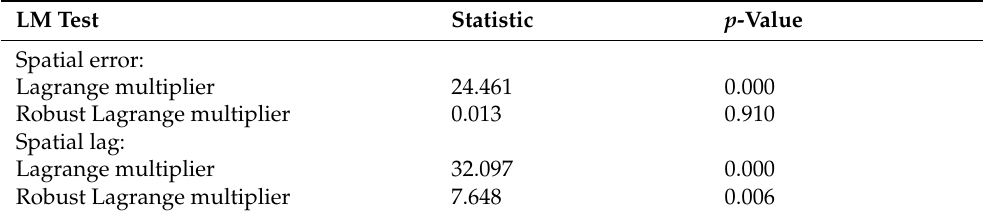
Table 2. LM test of spatial panel model (old residential buildings to install the number of